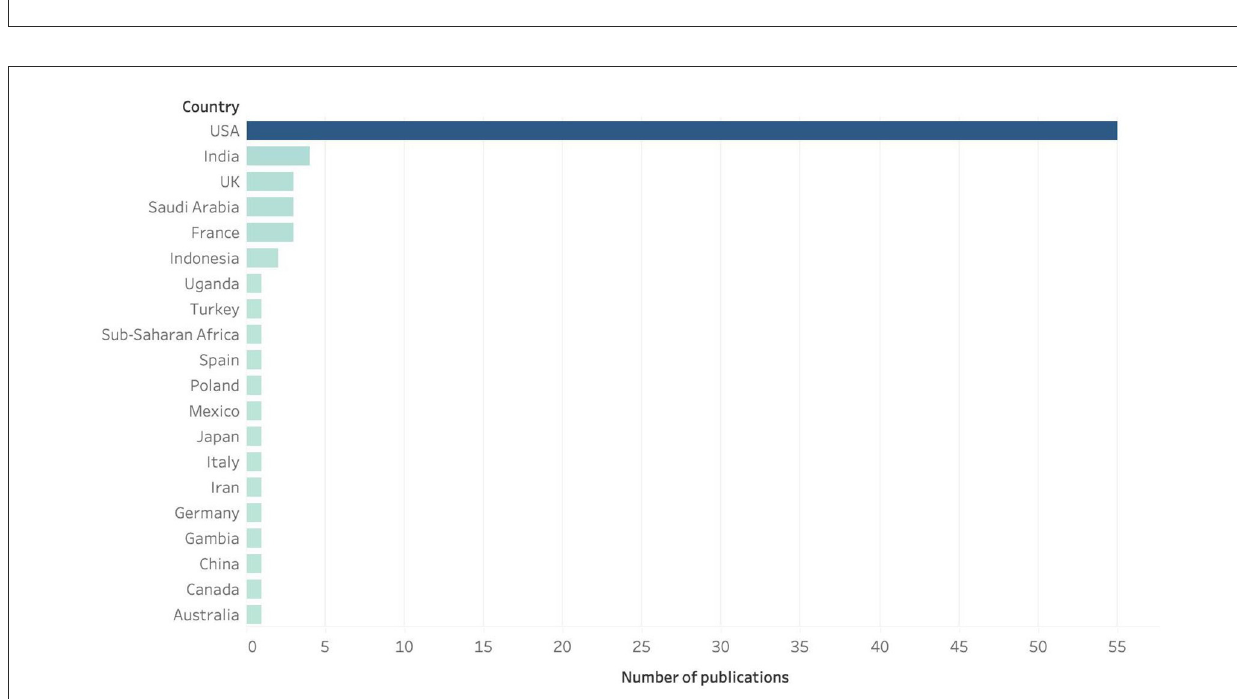
FIGURE6 Publications per